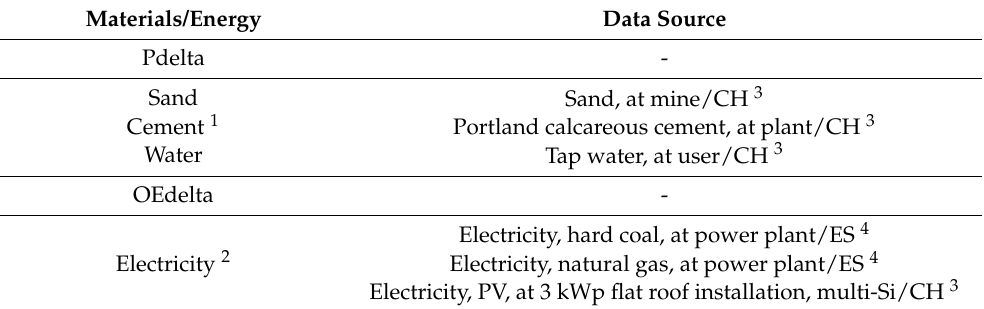
Table 4. Pdelta and OEdelta: data input from ecoinvent v3.2 database (SimaPro v9.1, European data